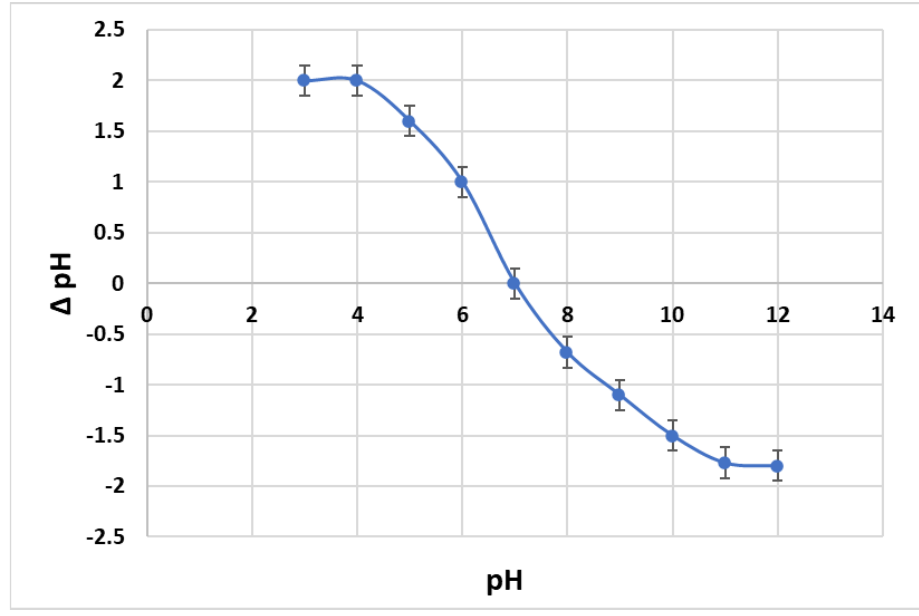
Figure 6. pH zpc . plot for 2Clph-BU-Cs.